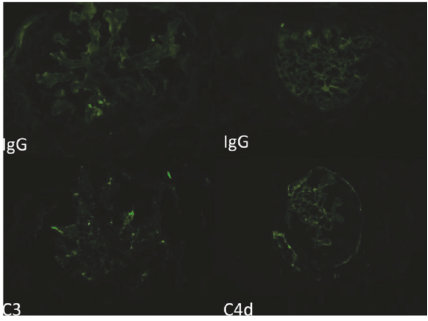
Figure 2: There is granular mesangial and capillary wall immunofluorescence staining for the respective immunoglobulins and complement components that range from 1 to 2+ on a scale of